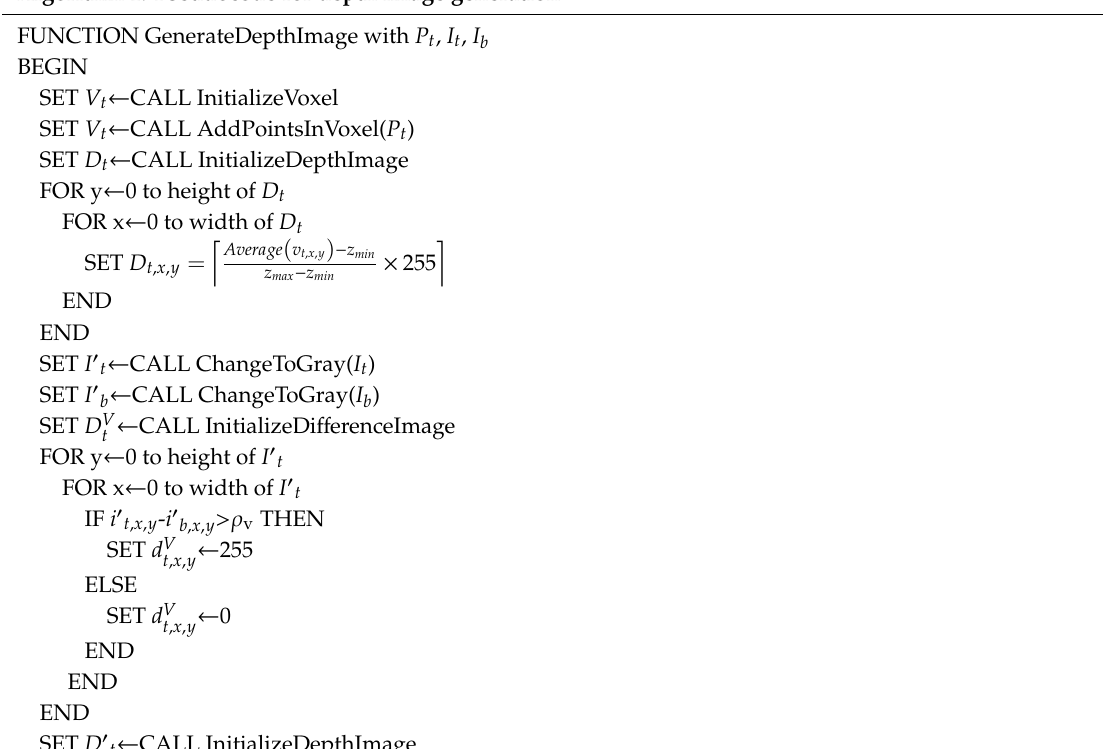
Algorithm 1: Pseudocode for depth image generation FUNCTION GenerateDepthImage with P t , I t , I